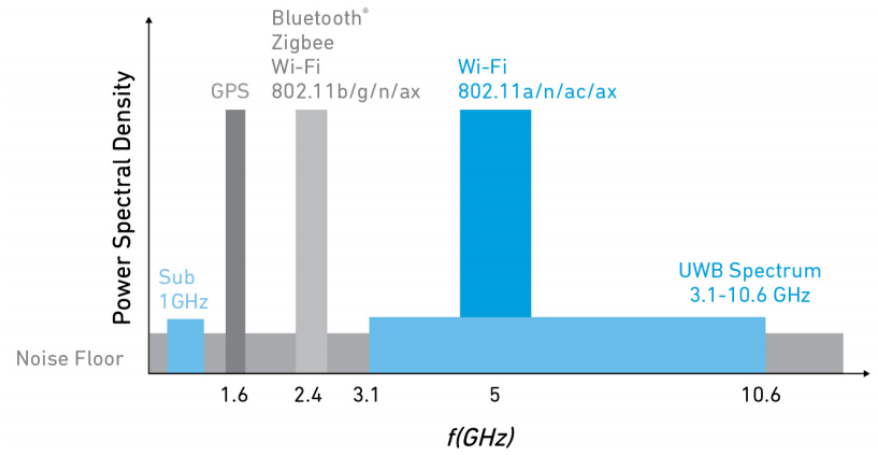
Figure 2. UWB interference with other wireless communication bands [1].